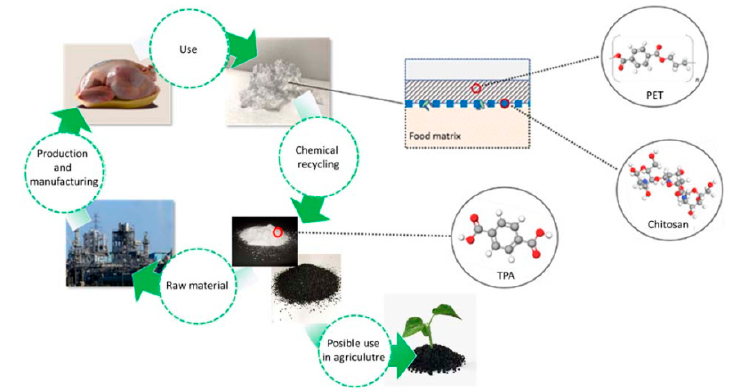
Figure 12. Circular-economy concept.